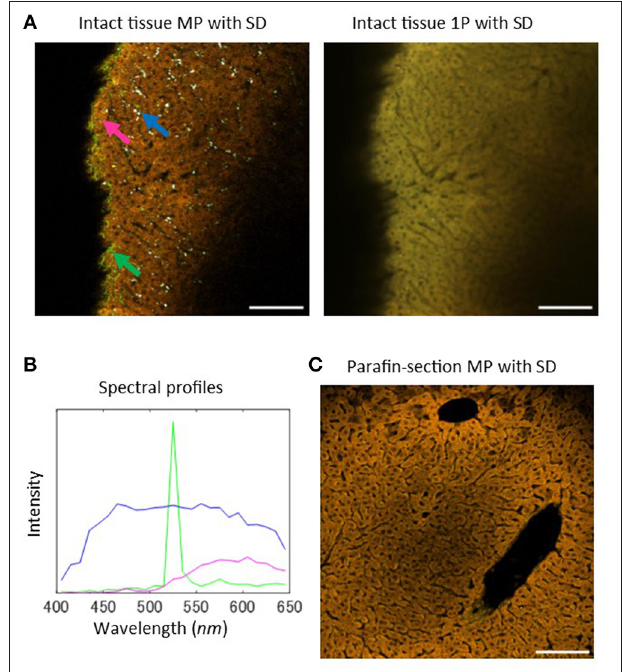
FIGURE 1 | Intrinsic emission spectral imaging of healthy mouse liver tissues with MP microscopy. (A) Laser scanning microscopy images of intrinsic emission light for healthy and intact mouse liver tissues. Left: MP excitation image through the SD unit with an excitation wavelength of 1,050nm. The emission spectra were detected as 25 channel images at a wavelength range of 400–650nm with a bandwidth of 10nm. Blue arrow indicates white-colored dot-like objects, green arrow indicates regions of emission of strong SHG signal, and magenta arrow indicates regions of hepatic parenchyma, primarily composed of hepatocytes. Right: 1P confocal laser scanning microscopy image through the SD unit. Four laser lines (405, 488, 561, and 640nm) were used for excitation. (B) Profiles of the emission spectra of the indicated arrows in (A) . (C) Sectional examinations for liver tissues. MP excitation spectral image of a paraffin-section. Scale bar: 100 µ